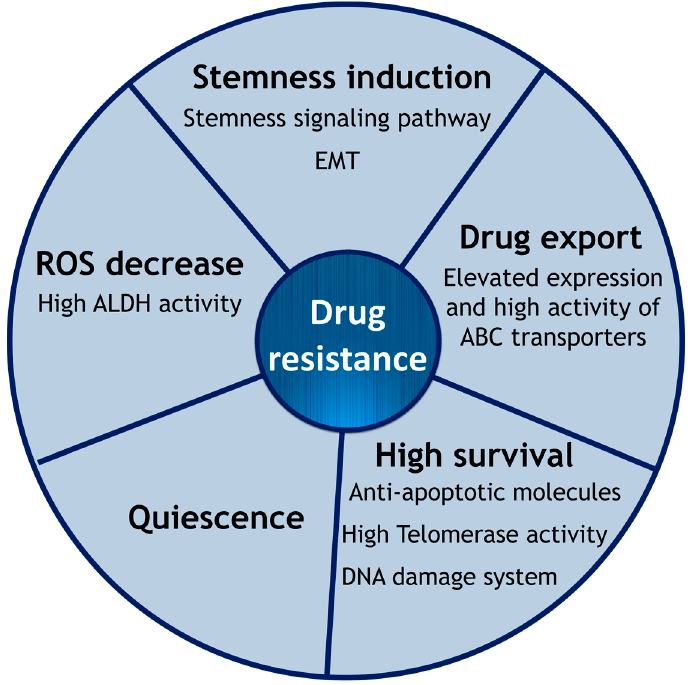
Figure 1. Radio- and chemotherapy resistance that CSCs intrinsically possess.